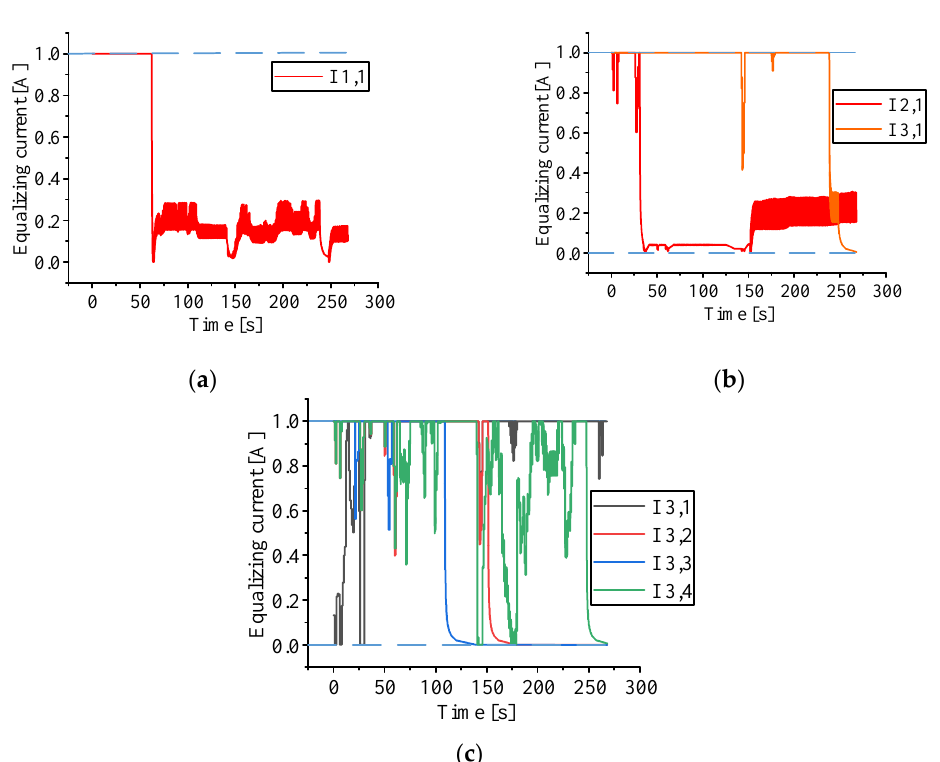
Figure 10. Lithium battery SOC difference diagram. (Multi-layer equalisation circuits and equali- sation strategies in this paper)